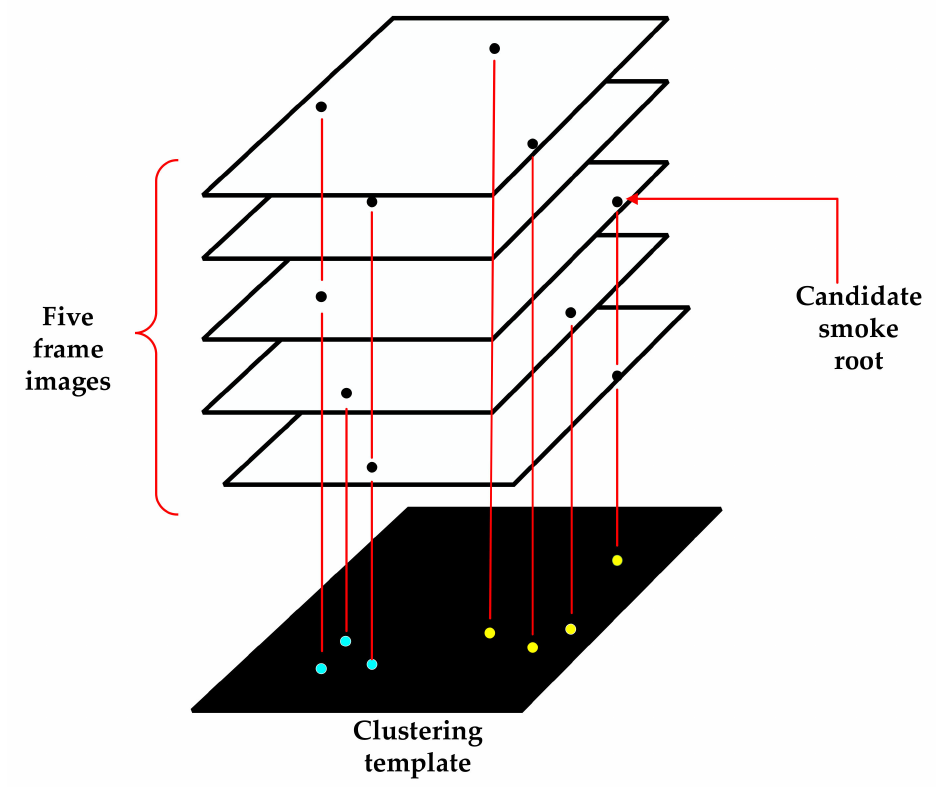
Figure 5. Smoke root